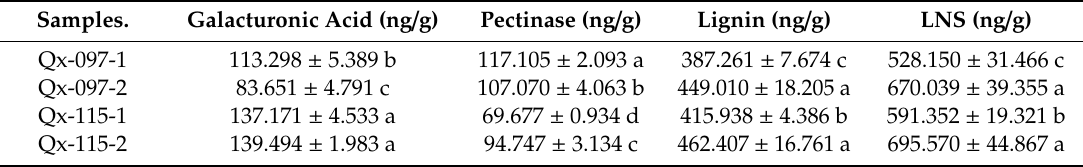
Table 2. Contents of galacturonic acid, pectinase, lignin, and lignin synthase (LNS) in anthers of ‘Qx-097 (cid:48) and ‘Qx-115 (cid:48) chrysanthemum cultivars. Samples.